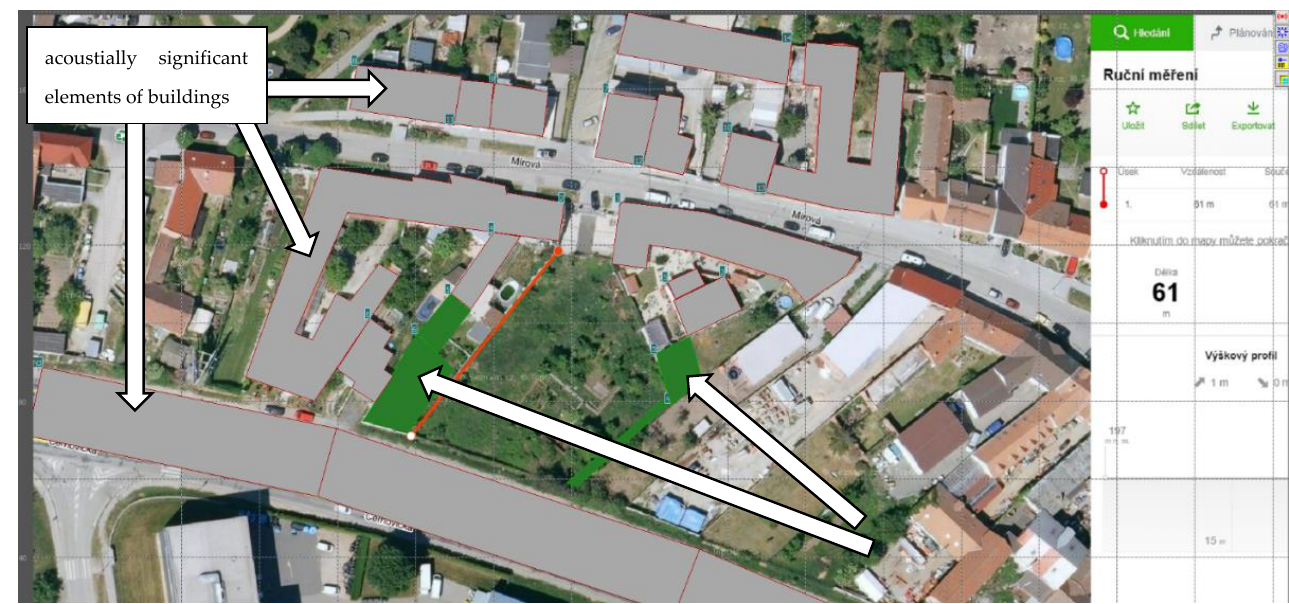
Figure 4. Acoustically significant elements in the investigated area.